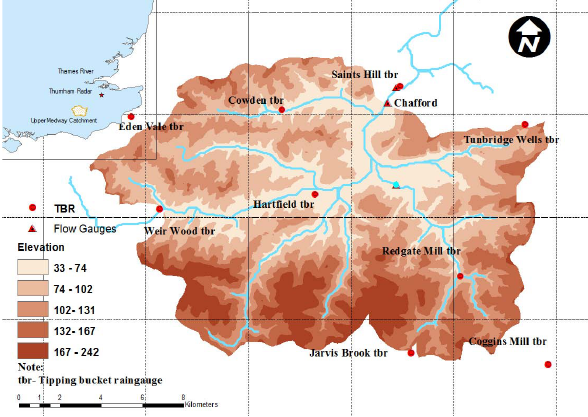
Fig. 1. Topographic and the river network map of the Upper Med- way